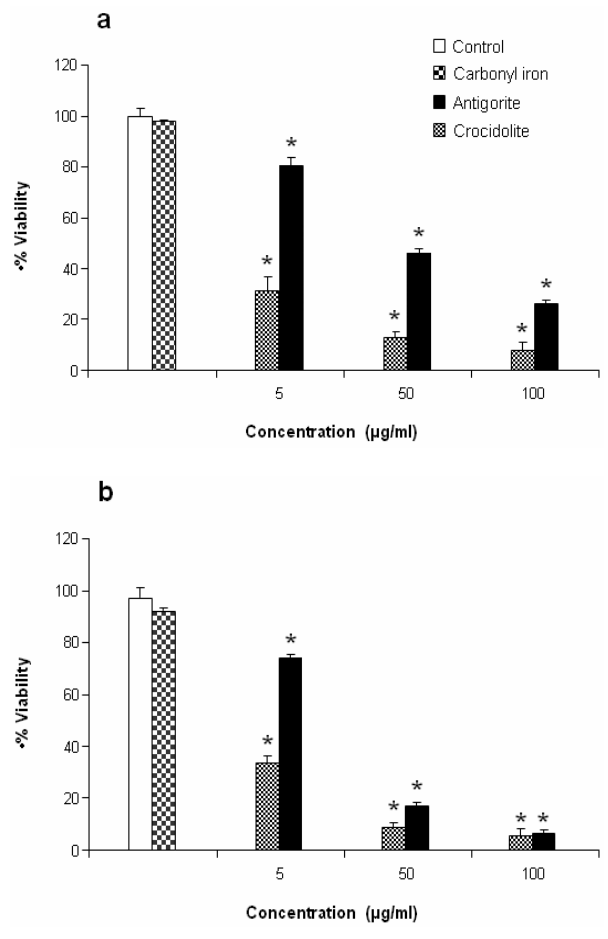
Figure 5: MeT-5A (a) and J774 (b) cell viability measured with tetrazolium salt assay (MTT). The values of optical density measured at = 550 nm are shown as percentage with respect to the optical density registered for untreated control, the latter considered as 100 % of cell viability. The values are the mean ± SEM of three experiments performed in triplicate. All values with P<0.01 were considered significantly different.